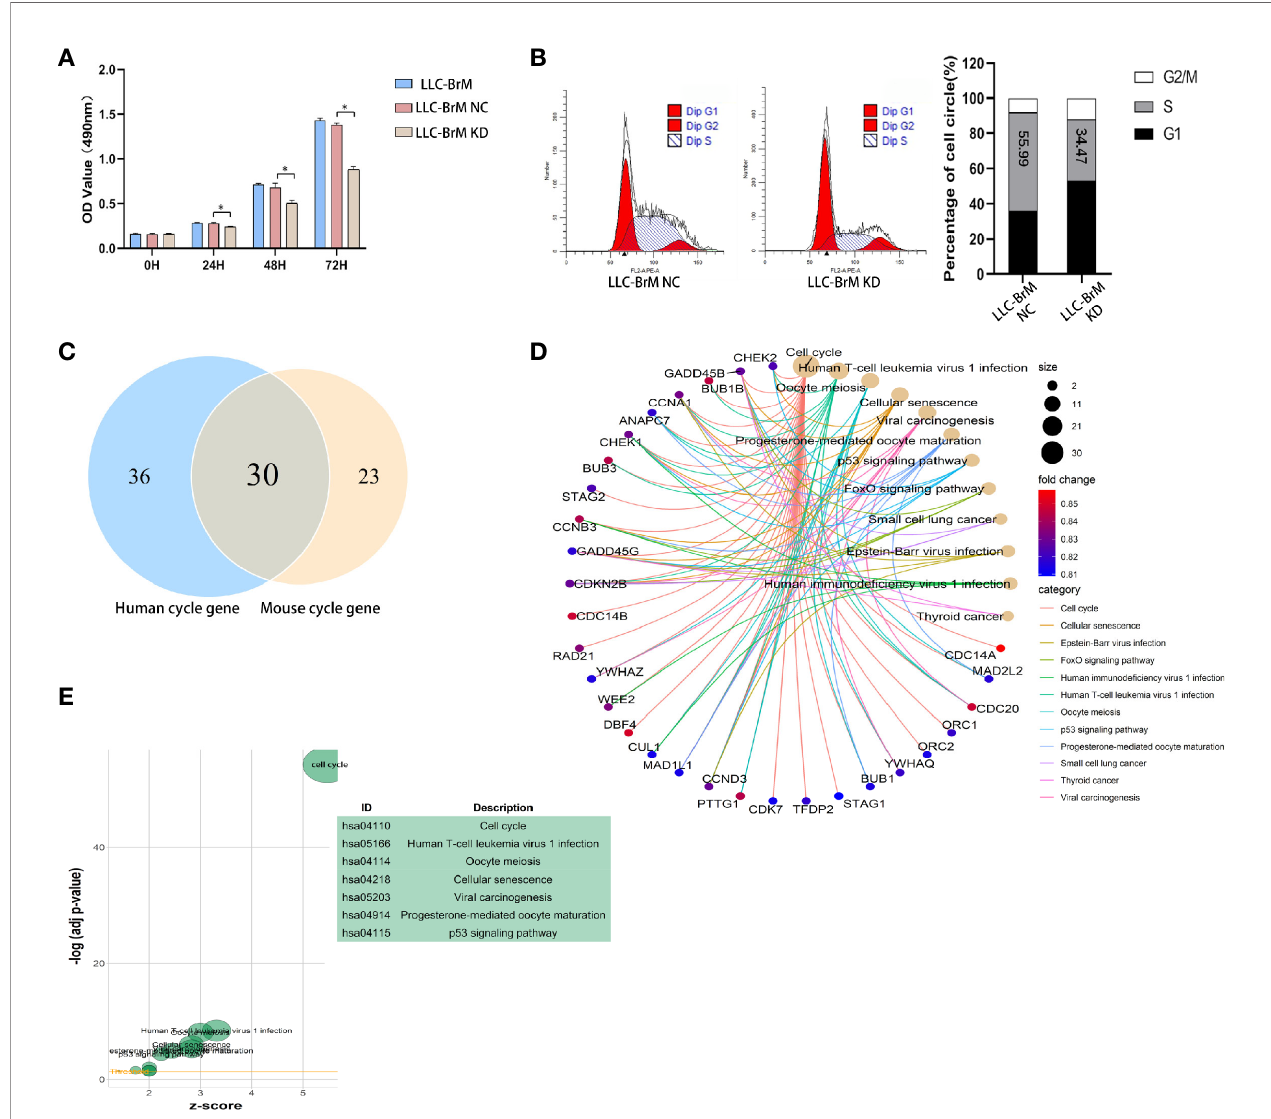
FIGURE 9 | HOXB9 promoted the proliferation of brain metastatic tumor cells through promoting the G1/S transition of the cell cycle. (A) Downregulation of HOXB9 in LLC-BrM decreased the proliferation, * p < 0.05. (B) Flow cytometry analysis determined the decreasing proportion of cells in the S phase of the cell cycle as the downregulation of HOXB9 in LLC-BrM. (C) Intersection analysis established the common cell-cycle-associated genes potentially transcribed by HOXB9 (Hoxb9) shared by both human and mouse. (D) Enrichment analysis of BP category in GO database for the 30 common genes potentially transcribed by HOXB9, terms enriched with p - and q -values were <0.05. (E) Enrichment analysis with signaling pathways in KEGG database for the 30 common cell cycle-associated genes. The p - and q -values of these enriched terms were both